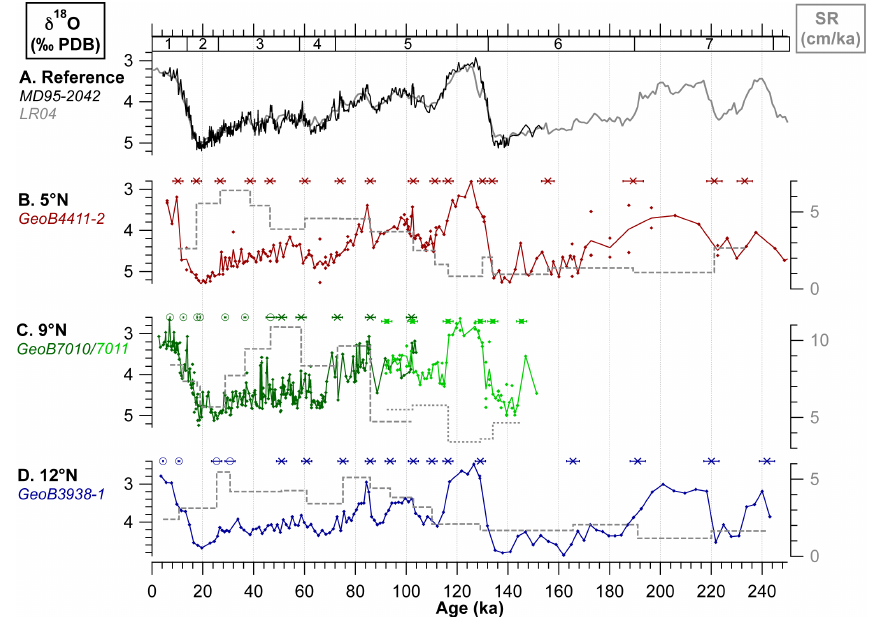
Fig. 3. Age models of the four studied sediment cores. (A) Reference records: benthic foraminiferal δ 18 O records from the North Atlantic core MD95-2042 (Shackleton et al., 2000, 2002) (black line) and from the LR04 stack (Lisiecki and Raymo, 2005) (grey line). (B) – (D) Benthic δ 18 O record (plain line, left y axis), sedimentation rate (SR) variations (grey dashed line, right y axis) and tie points (open circles for 14 C dates, crosses for tie points based on benthic synchronization, with 1 σ errors) defined in cores (B) GeoB4411-2 (5 ◦ N, red), (C) GeoB7010-2 (9 ◦ N, dark green) and GeoB7011-1 (9 ◦ N, light green), and (D) GeoB3938-1 (12 ◦ N, blue). Marine isotope stages are indicated at the top of (A)